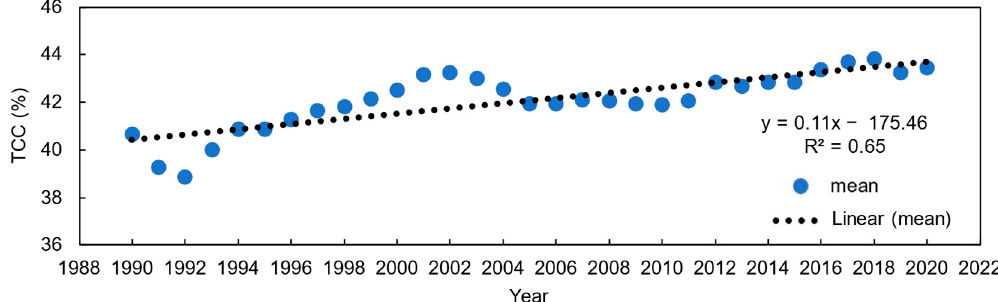
Figure 7. Interannual variability in TCC from 1990 to 2020 in the Eastern Himalayas.